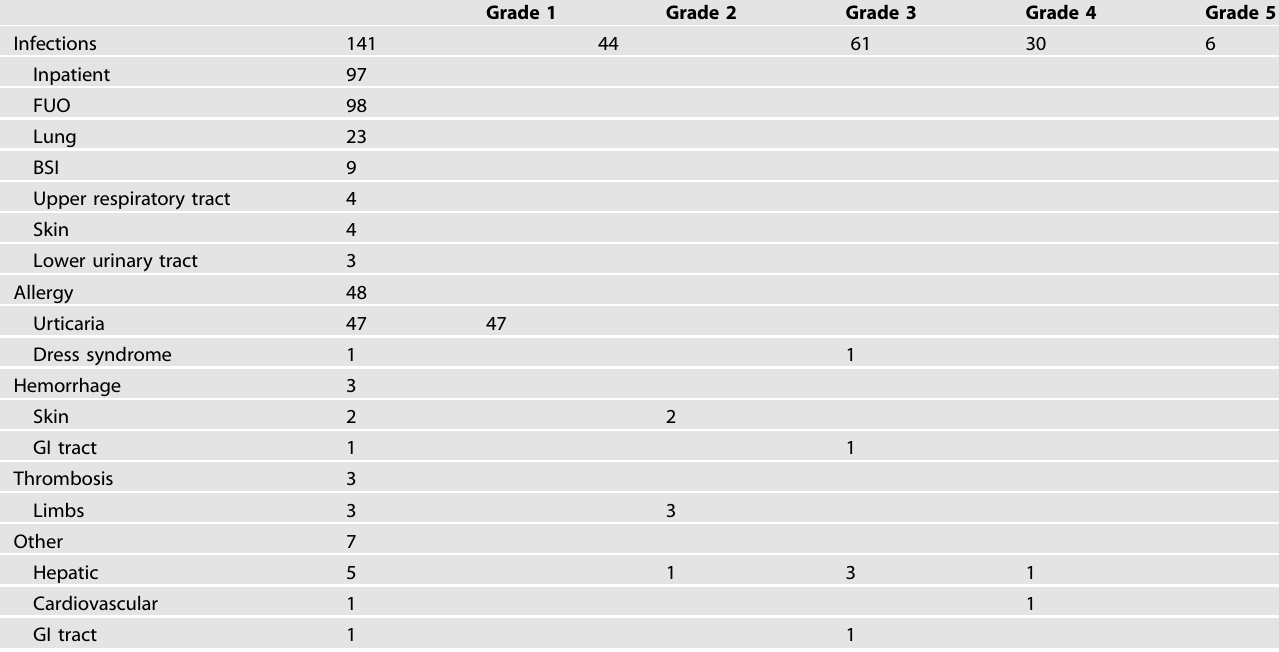
Table 4. Adverse events and